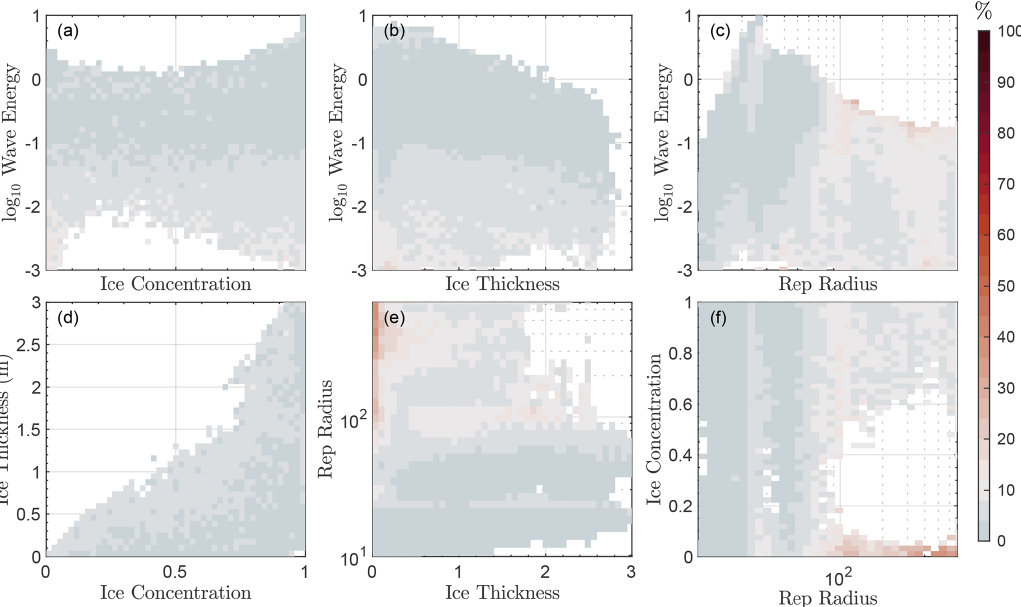
Figure 3. Examination of training errors in NN-WIFF. (a) 2-D map of median SSE as a function of ( x axis) sea ice concentration and ( y axis) log 10 E from the validation dataset. (b–f) Same as (a) but for (b) H and log 10 E , (c) R and log 10 E , (d) C and H , (e) H and log 10 E , and (f) R and C . Regions are not colored for less than 0.005% ( ∼ 40